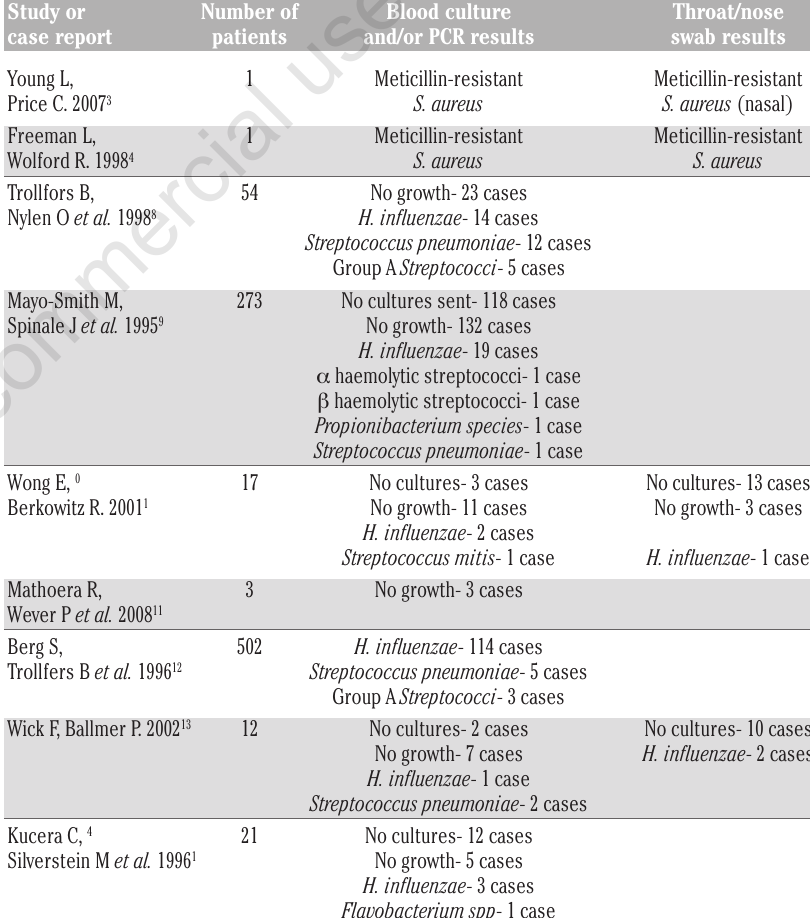
Table 2. Previous studies into the epidemiology of adult